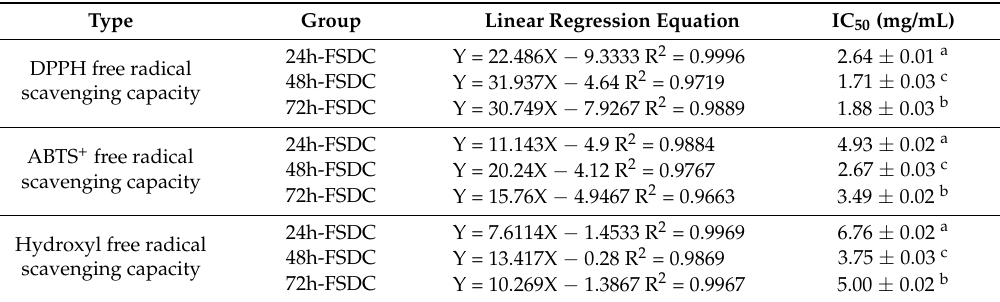
Values presented are the mean ± standard deviation. a–c Mean values with different letters in the same row are significantly different ( p <0.05). 24h-FSDC: 24 h fermented Shuidouchi; 48h-FSDC: 48 h fermented Shuidouchi; 72h-FSDC: 72 h fermented Shuidouchi. 3.5. Comparison of Soybean Isoflavone Contents of Shuidouchi Soaked in Different Water Quantities The soybean isoflavone contents in fermented Shuidouchi extract that was soaked in different quantities of water were 40.35, 58.87, and 56.37 mg/g (genistein meter), respectively. Unfermented soybeans contained 33.71 mg/g soybean isoflavone, which was in accordance with the standard curve for genistein, Y = 0.1709X + 0.0095 (Figure 7).